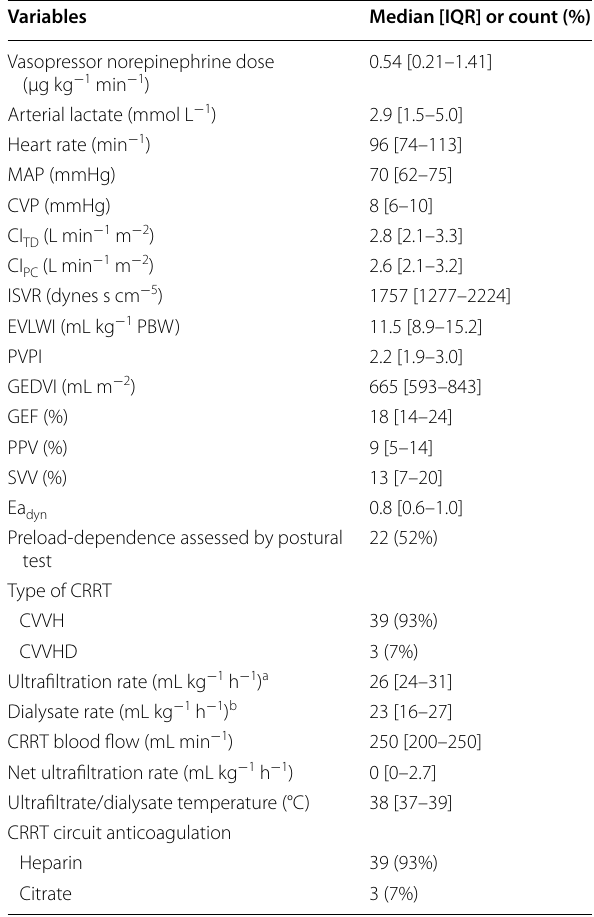
Table 2 Hemodynamic data and CRRT settings at